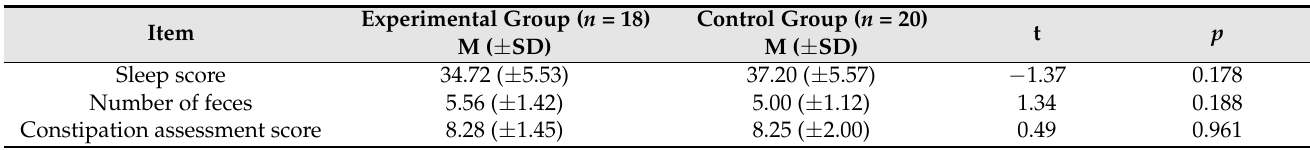
Table 2. Homogeneity Test for the Dependent Variables of the Experimental Group and the Control Group ( n = 38).